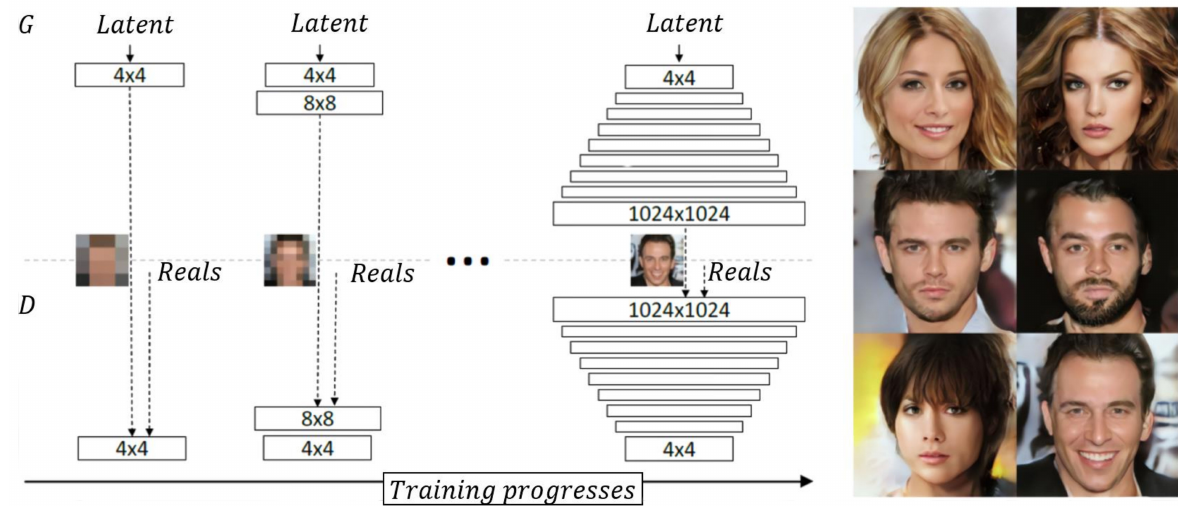
Figure 7. Training process of PGGAN (Progressive Growing of Generative Adversarial Networks) [7]. The added layer does not freeze but continues training. This algorithm was applied to the LSUN (large scale scene understanding) dataset image to obtain the results shown in Figure 8 [31].